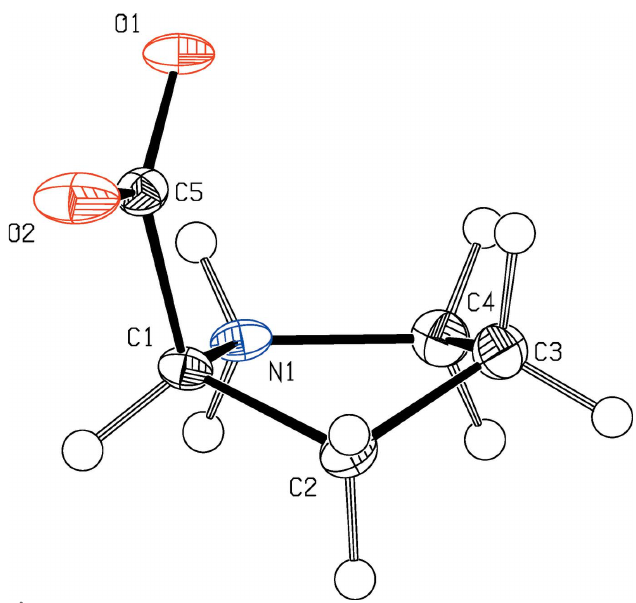
Figure 1 The molecular structure of the title compound l -proline. Displacement ellipsoids are drawn at the 50% probability